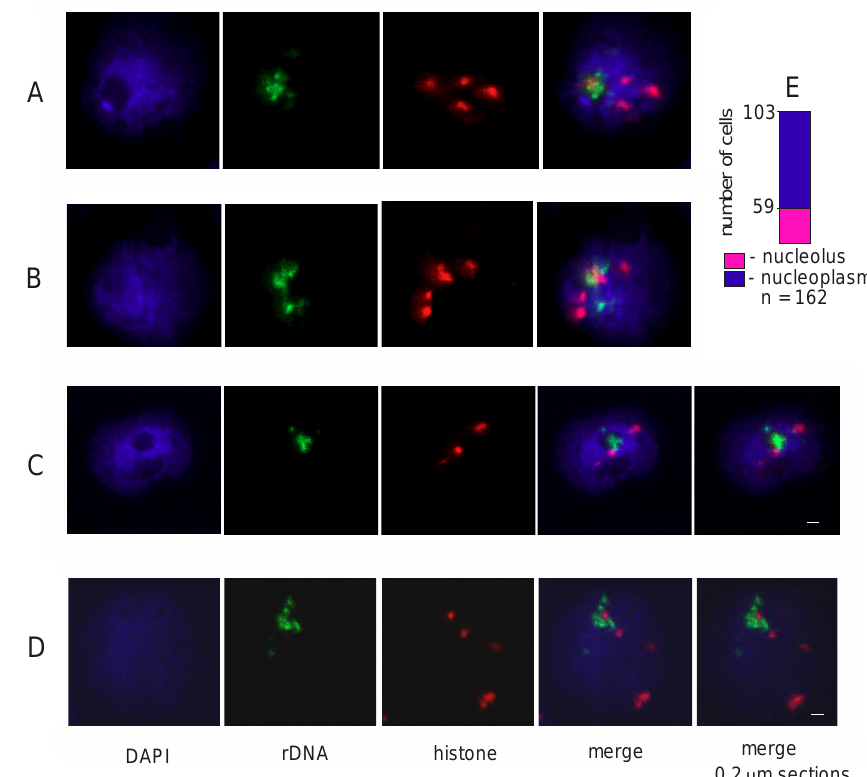
Figure 3. Two-color DNA-FISH with rDNA and histone gene probes. ( A – D ) Nucleoli demonstrating colocalization of rDNA units (Alexa 555) and histone genes (Alexa 650). The images shown here were cropped from populations of cells to highlight the localization of foci in a single cell. ( C , D ) Nucleoli analyzed with 0.2-μm z-step sections. Scale bar: 1 μm. ( E ) The results of population analysis of the histone foci localized either in the nucleoplasm or at the nucleoli in 162 cells are shown by the bar.